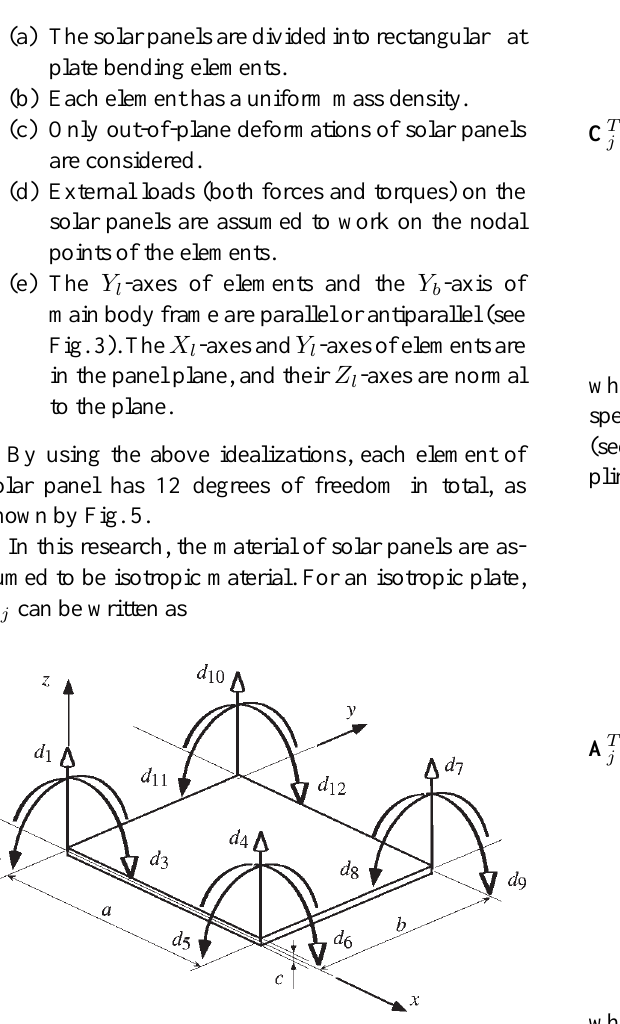
Fig. 5. A rectangular plate bending element model of solar